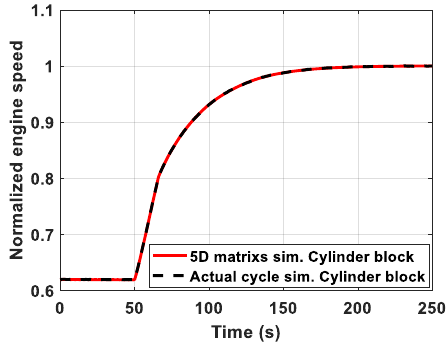
Figure 15. Engine speed time history.